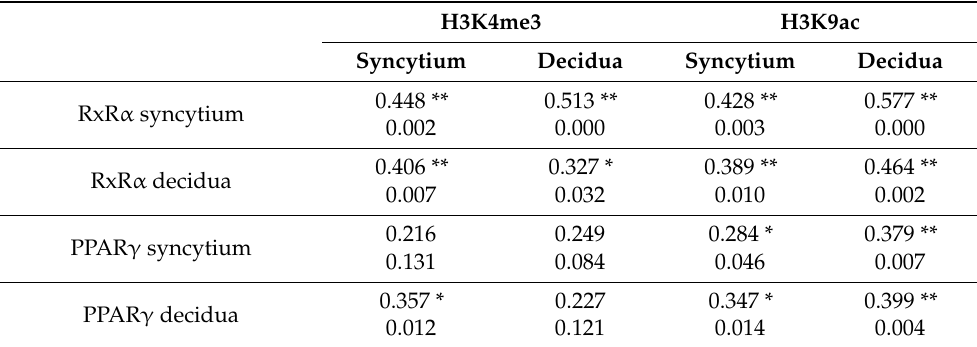
Table 1. Correlations of the histones with other proteins. The upper value is the correlation factor r, the second value is the p -value. * significant ( p < 0.05), ** highly significant ( p < 0.01)